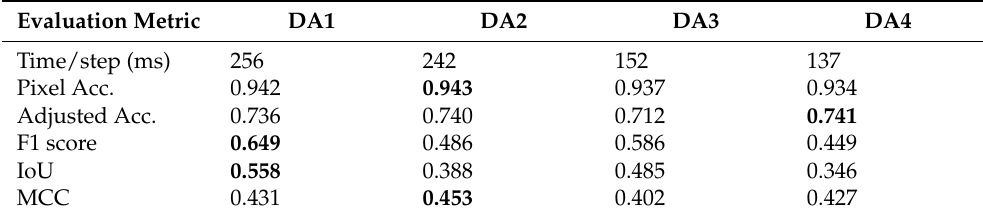
Table 4. Experiments carried out in different settings of supervised DA. The highest values are highlighted in